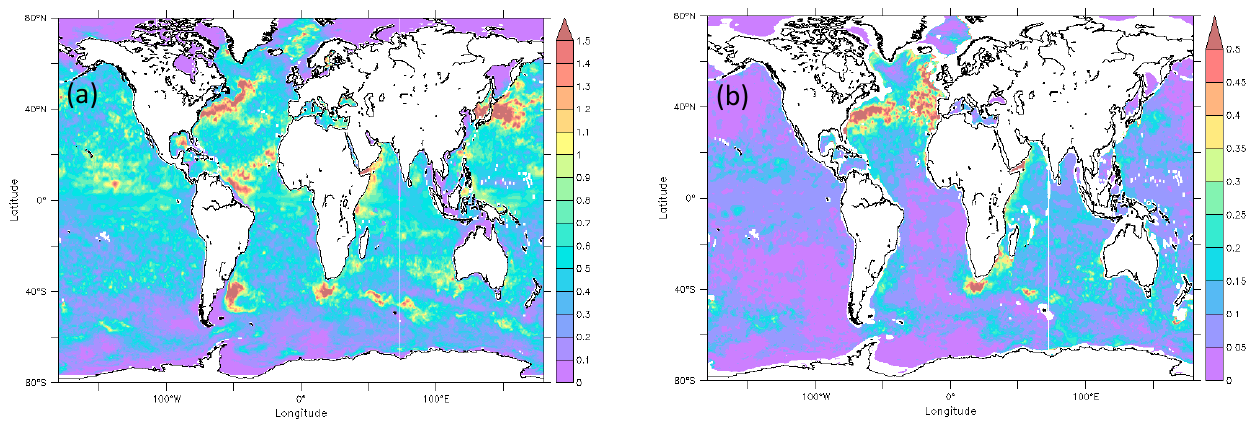
Figure 6. The RMS of temperature differences between Run-Ref and Run-NoArgo in the 0–300m layer (a) and in the 700–2000m layer (b) for the last 6 months of the experiments.